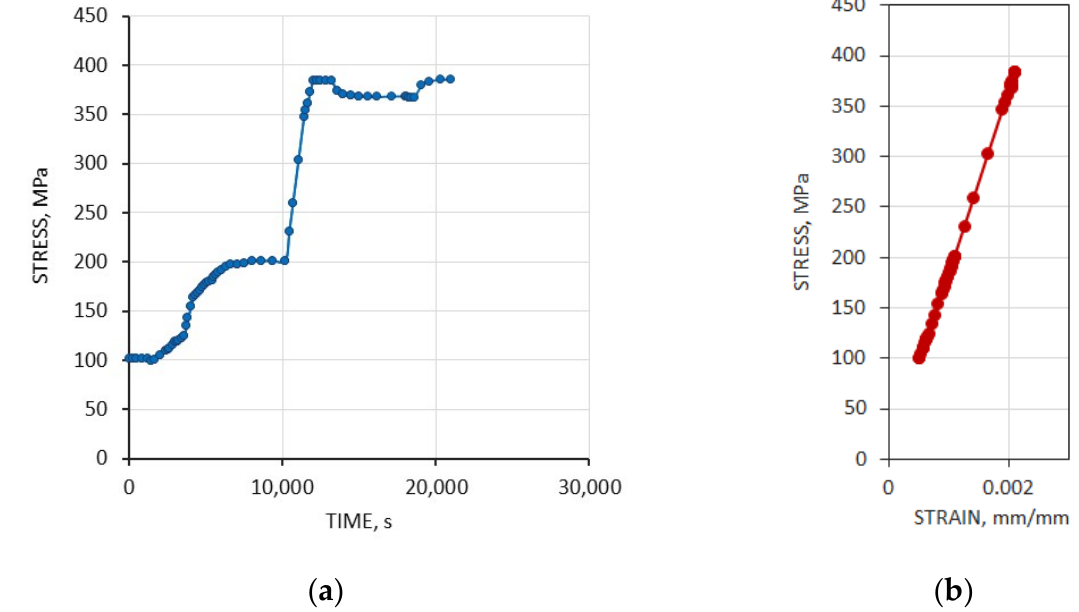
Figure 11. The ( a ) stress versus time and ( b ) stress versus strain relationships in the OR HOT startup scenario under industrial operating conditions.